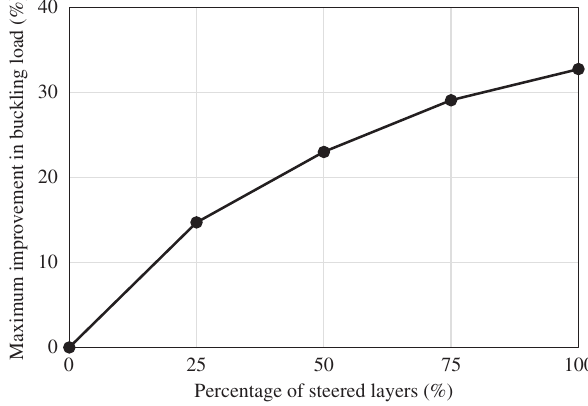
Figure 8: Maximum buckling load improvement of VS over QI lami- nate in terms of the percentage of the number of plies considered for fiber steering.